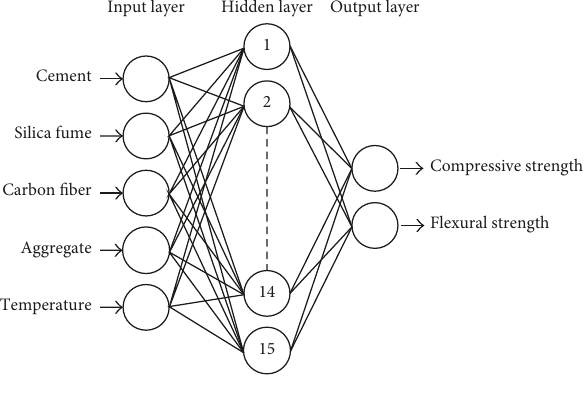
Figure 9: ANN architecture.